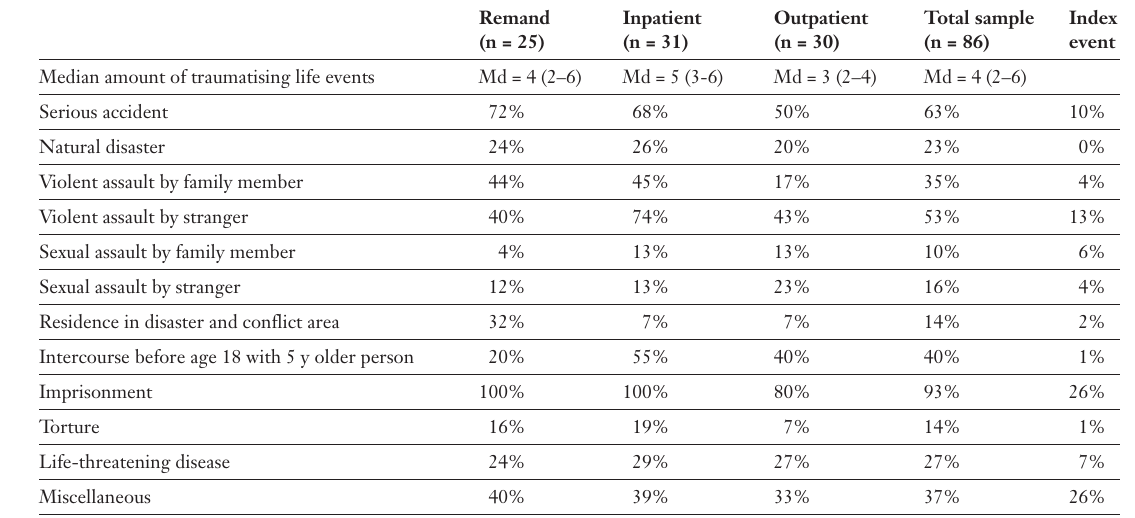
Table 2 Amount and type of traumatic life events.